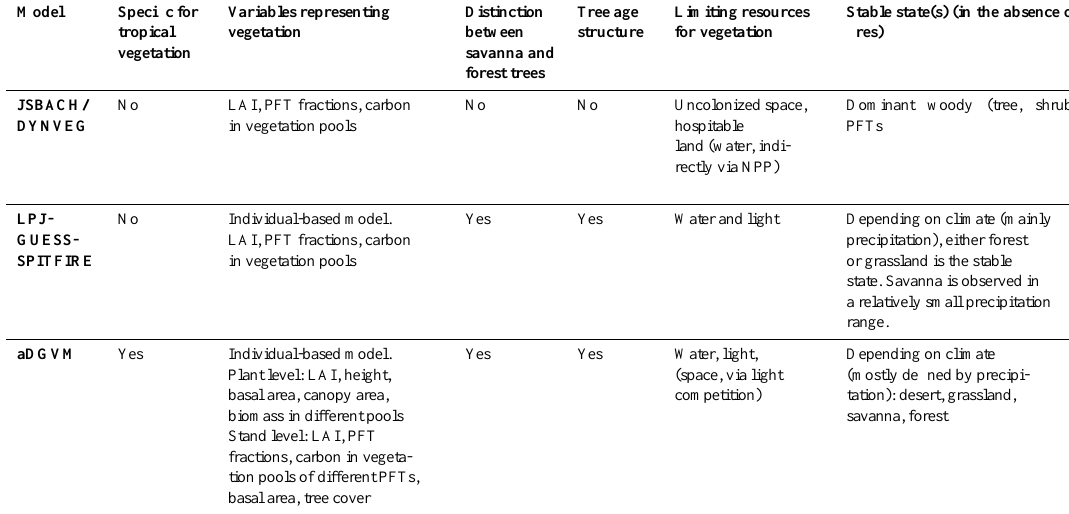
Table 1. Models and their specifics concerning the tree–grass